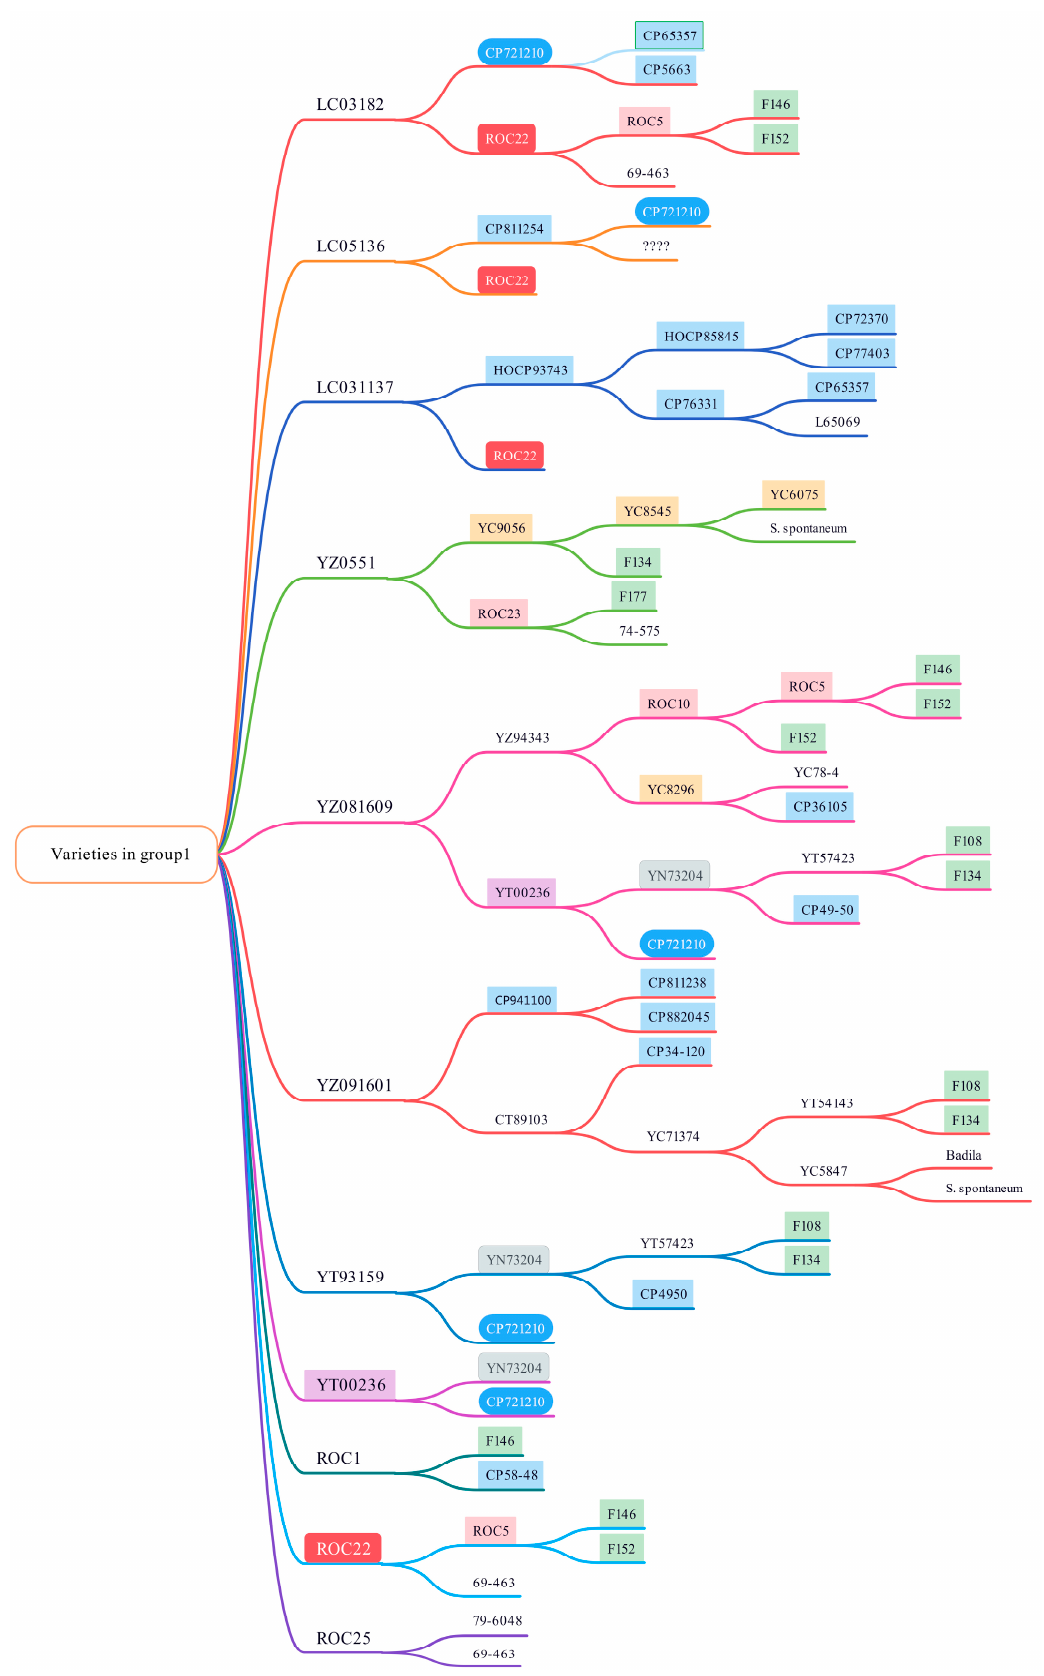
Figure 5. Parent traceability analysis of the group 1 varieties. “?”: no parental information available.